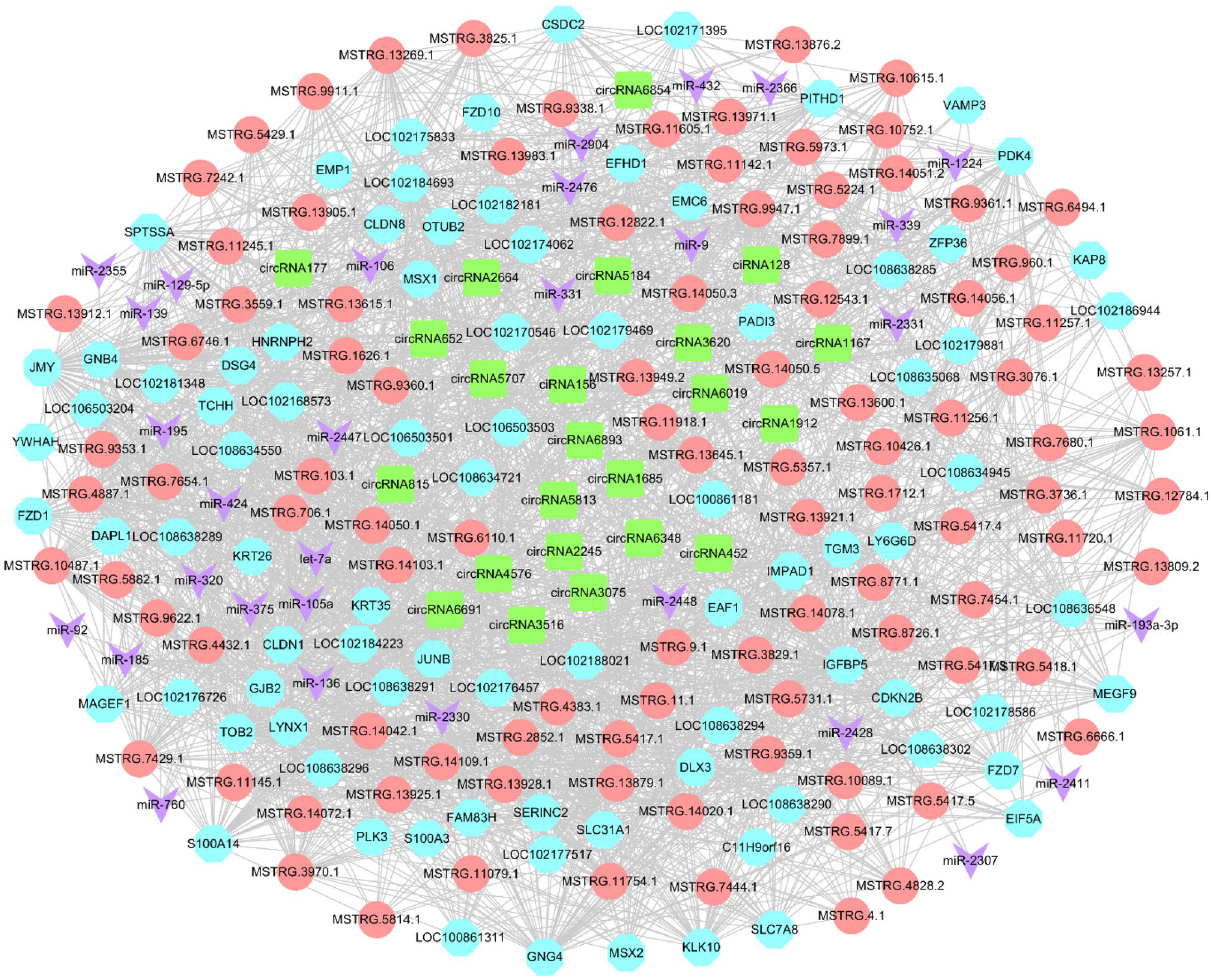
Figure 9. Regulation network of lncRNA/circRNA–miRNA–mRNA. Pink: lncRNAs, green: circRNAs, blue: mRNAs, purple: